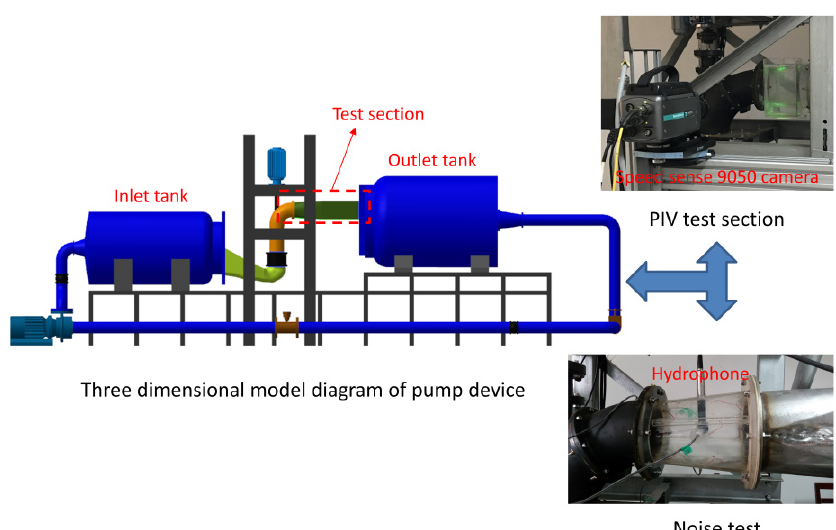
Figure 6. Vertical axial-flow pump test device.